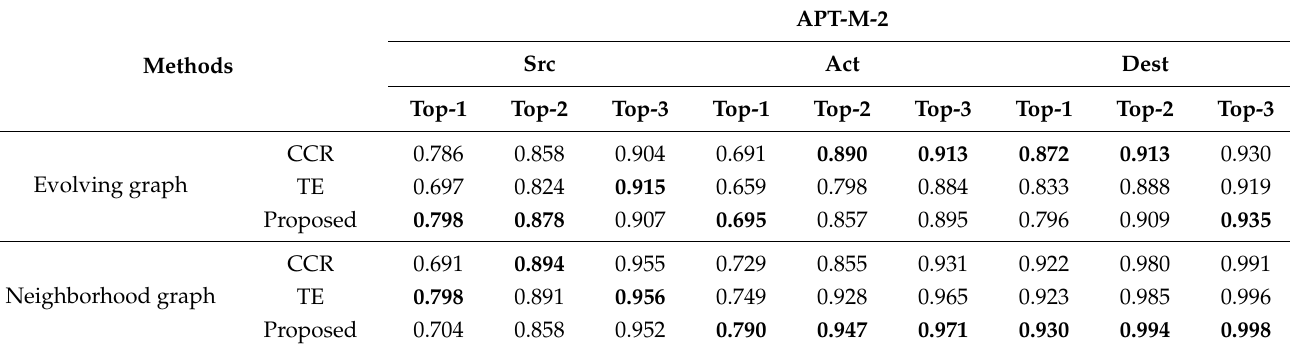
Table 8. Performance based on